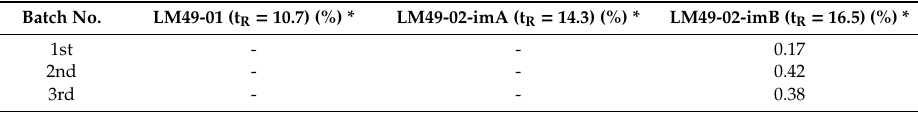
Table 10. The impurity profile of three batches for the bromination